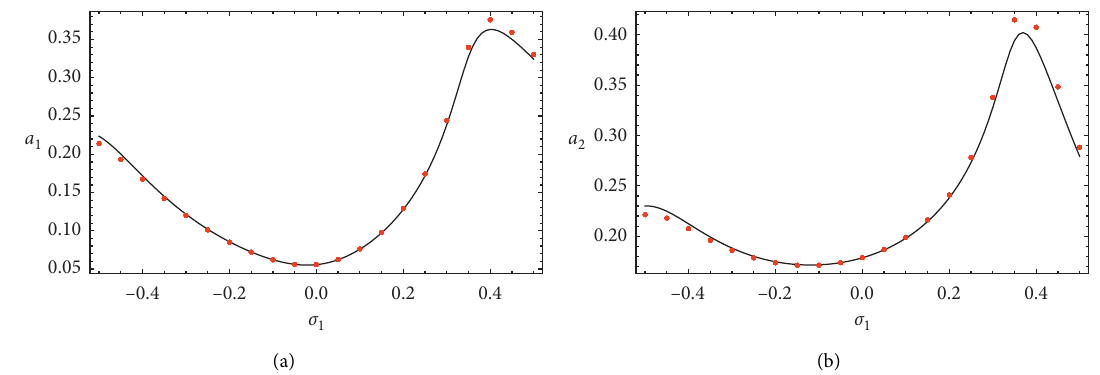
Figure 12: Frequency σ main system; (b) the controller.